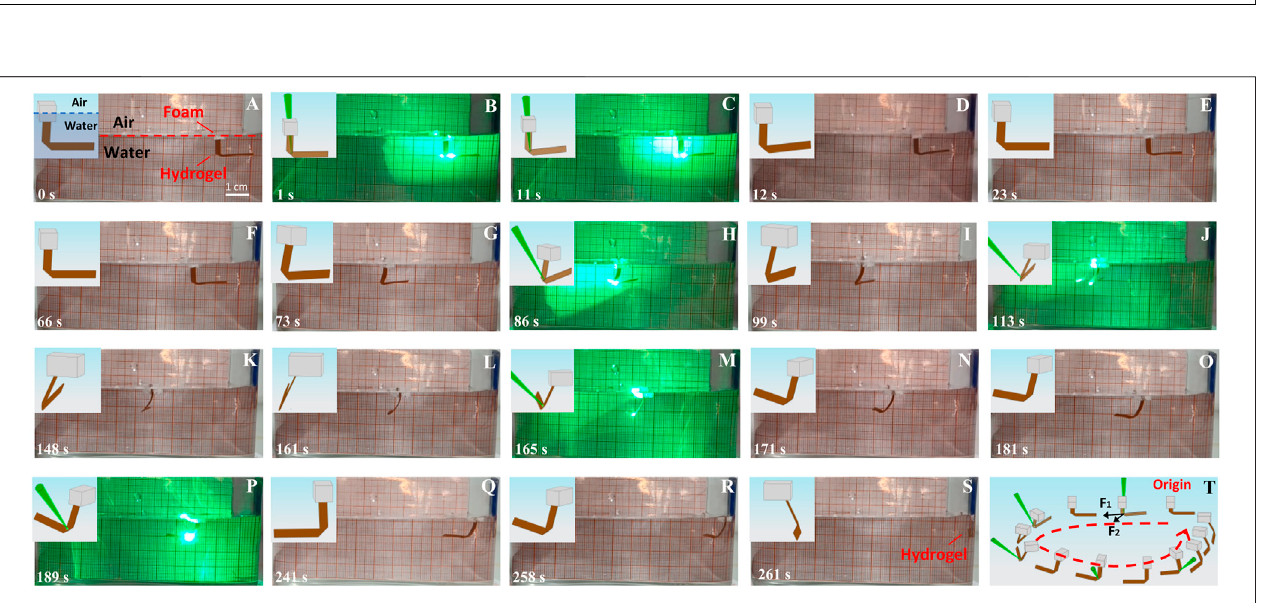
Frontiers in Materials |